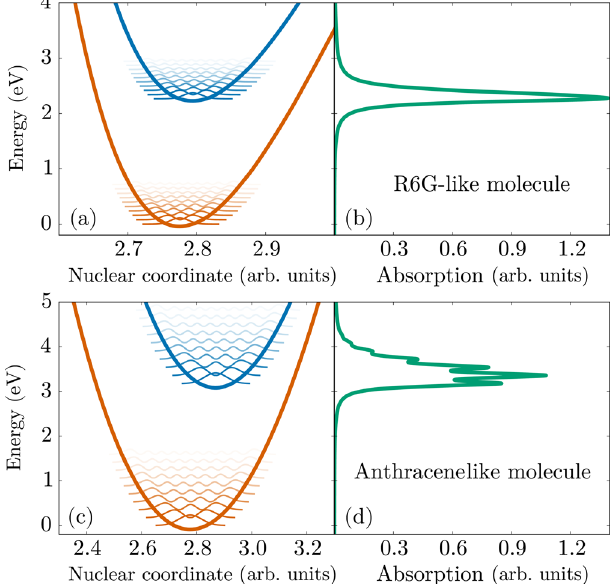
FIG. 2. Bare-molecule potential energy surfaces of the two first electronic states in the BOA for (a) the rhodamine 6G-like model molecule and (c) the anthracenelike model molecule. The vibra- tional levels and associated nuclear probability densities are represented on top of the PES. (b), (d) Absorption spectrum for the (b) R6G-like and (d) anthracenelike molecule in arbitrary units.